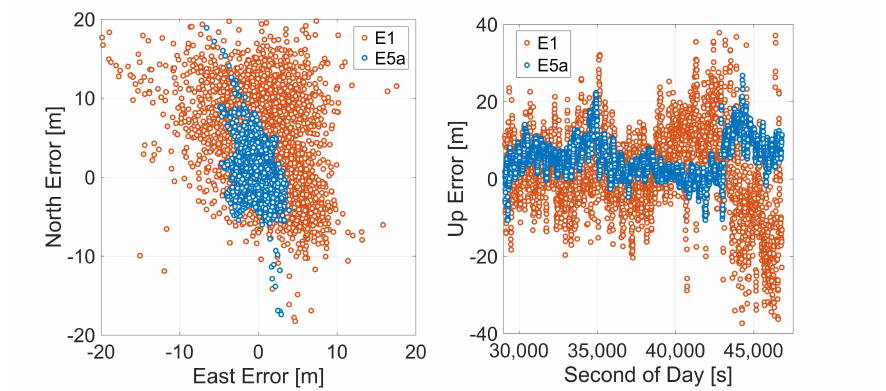
Figure 16. Horizontal and vertical coordinate component error scatter plots for Galileo single point positioning of Xiaomi Mi 9. Red markers represent an E1-based solution, while blue ones correspond to the E5a-based